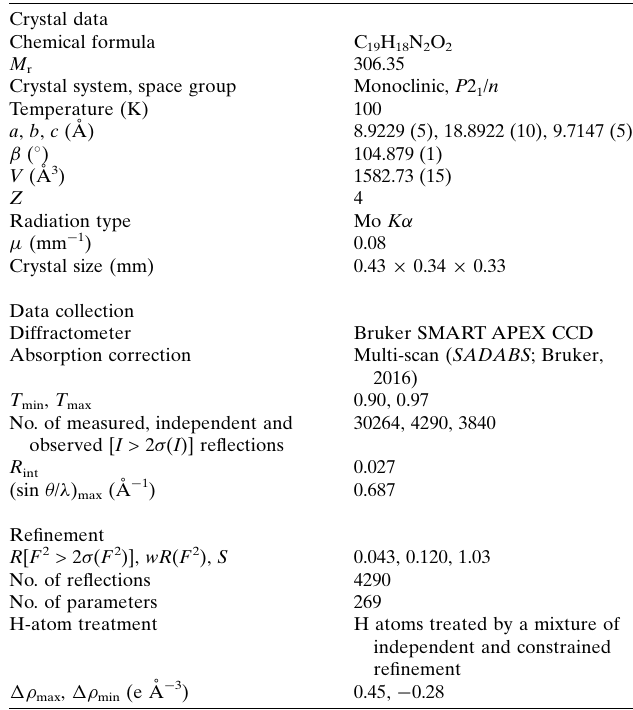
Table 2 Experimental details. Crystal data Chemical